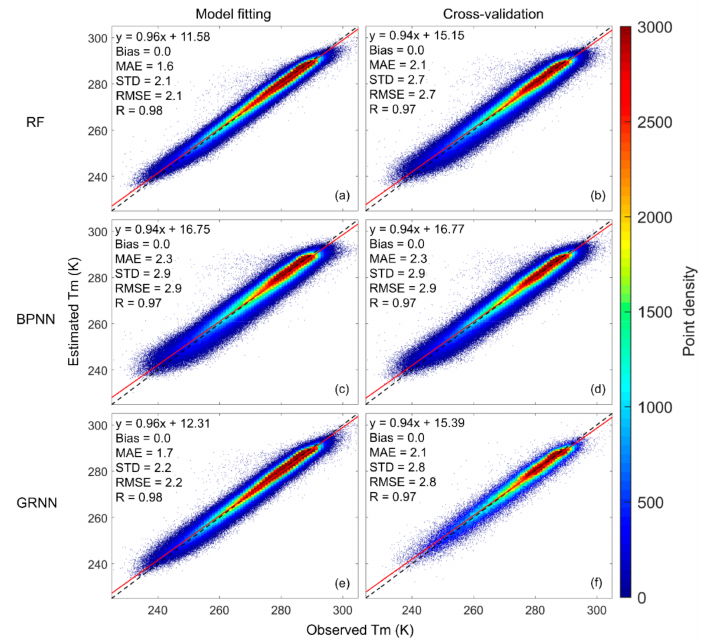
Figure 5. Scatter plots of estimated the weighted mean temperature ( T m ) against observed T m for different models: ( a ) RF-model fitting; ( b ) RF-cross-validation; ( c ) BPNN-model fitting; ( d ) BPNN- cross-validation; ( e ) GRNN-model fitting; ( f ) GRNN-cross-validation. The dashed line is the 1:1 line. RF: random forest; BPNN: backpropagation neural network; GRNN: generalized regression neural network.